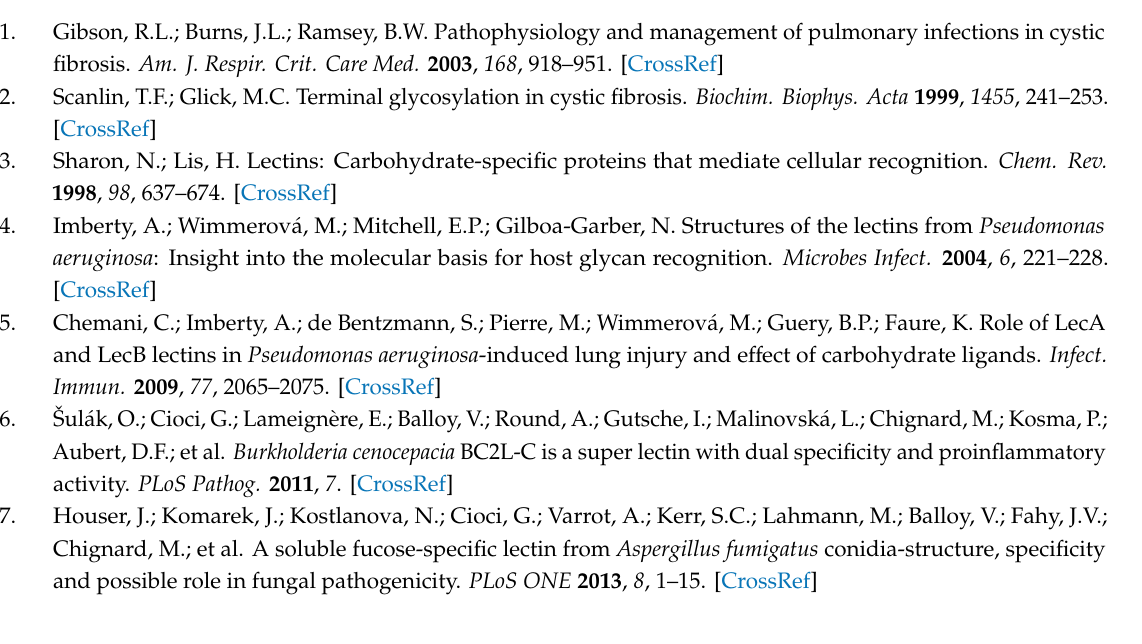
Supplementary Materials: The following are available online: Figure S1: Influence of l -fucose, compounds 1 , 2 , 3 , 4 and 5 on hemagglutination caused by lectin AFL. Figure S2. Influence of l -fucose, compounds 1 , 2 , 3 , 4 , 14 and 5 on hemagglutination caused by lectin RSL. Figure S3. Influence of l -fucose, compounds 1 , 2 , 3 , 4 and 5 on hemagglutination caused by lectin AAL. Figure S4. Influence of l -fucose, compounds 1 , 2 , 3 , 4 and 5 on hemagglutination caused by lectin AOL. Figure S5. Influence of l -fucose, compounds 1 , 2 , 3 , 4 and 5 on hemagglutination caused by lectin